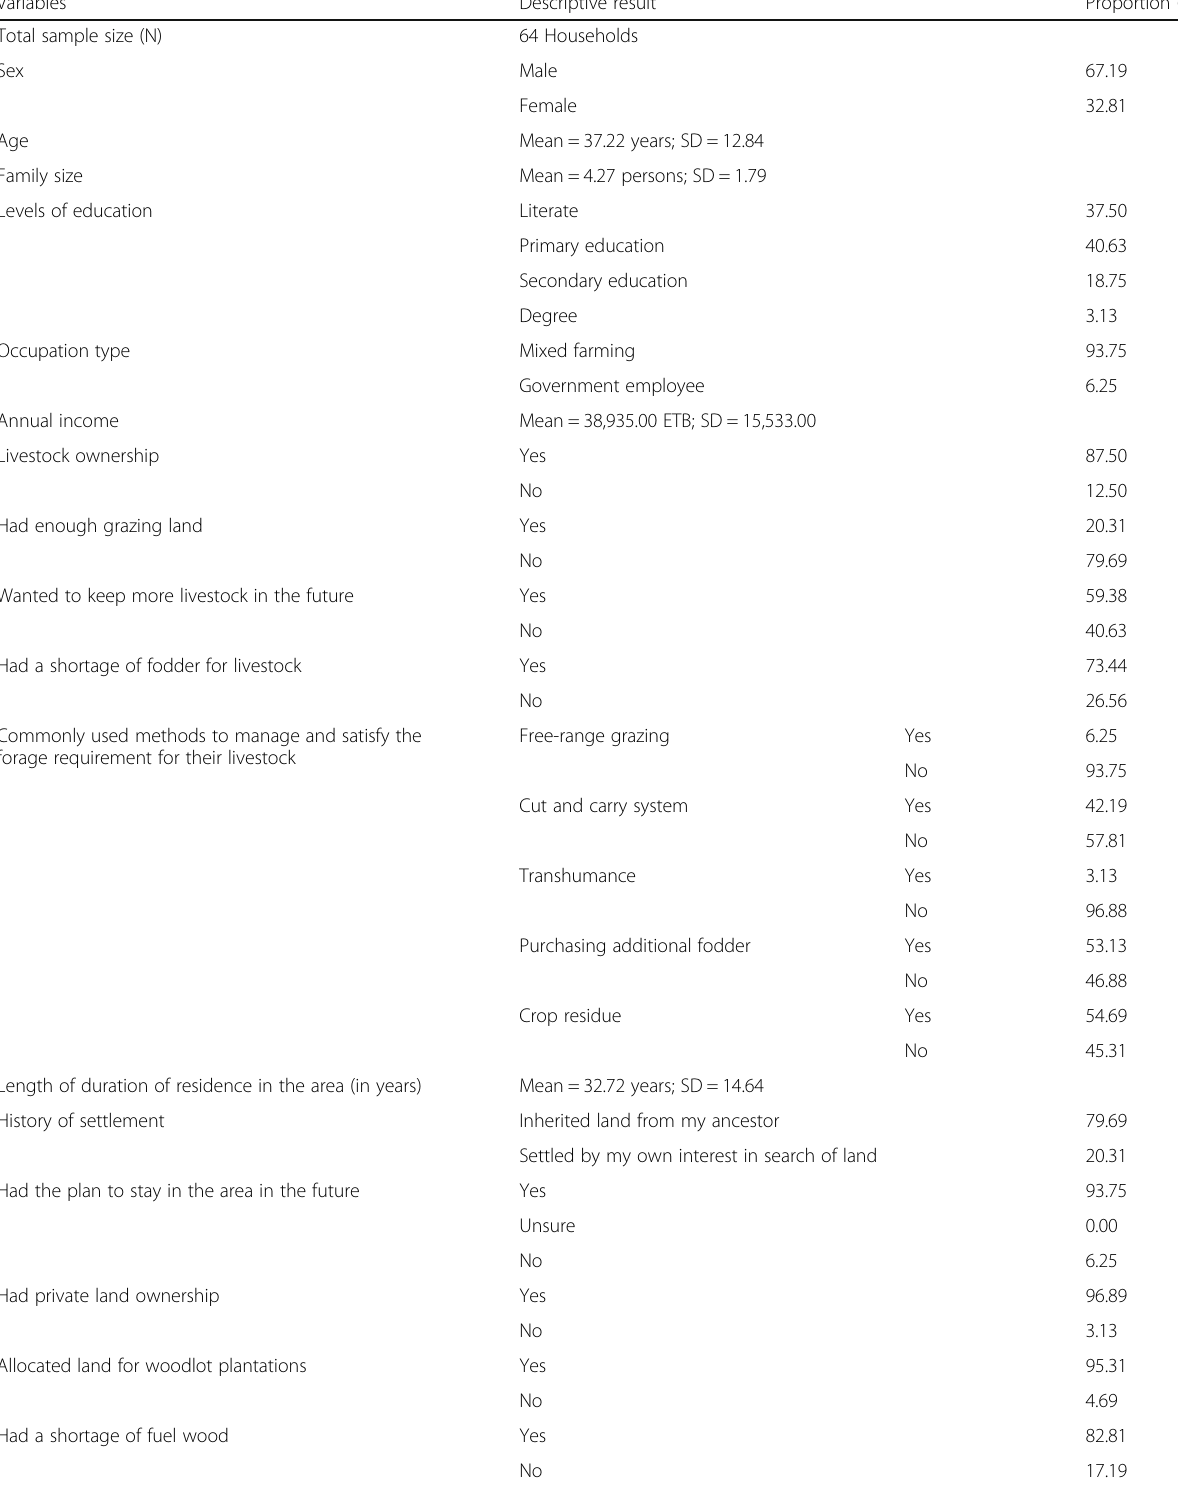
Table 2 Socio-economic characteristics and descriptive